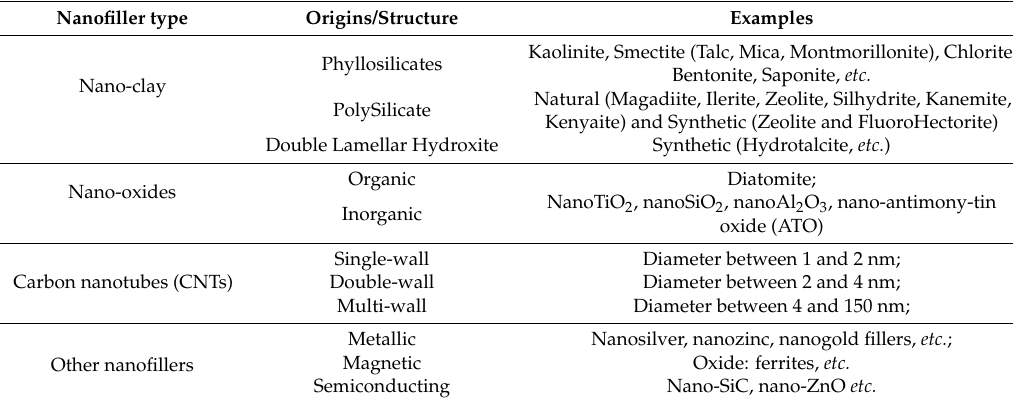
Table 2. Examples of different types of nanofillers (Adapted table from